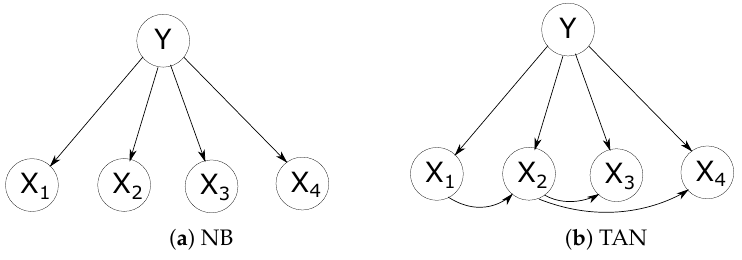
Figure 1. Structure of NB and